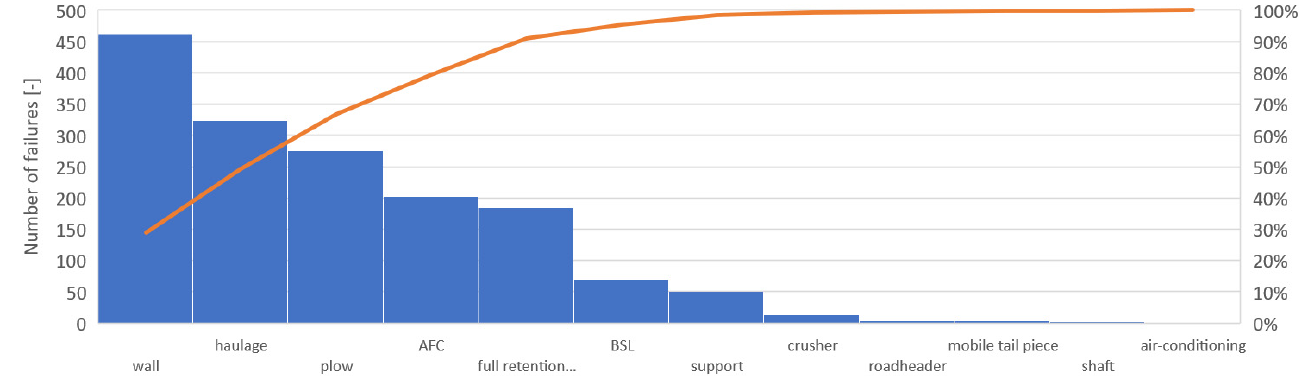
Figure 10. Pareto chart for the total number of plow longwall failures.